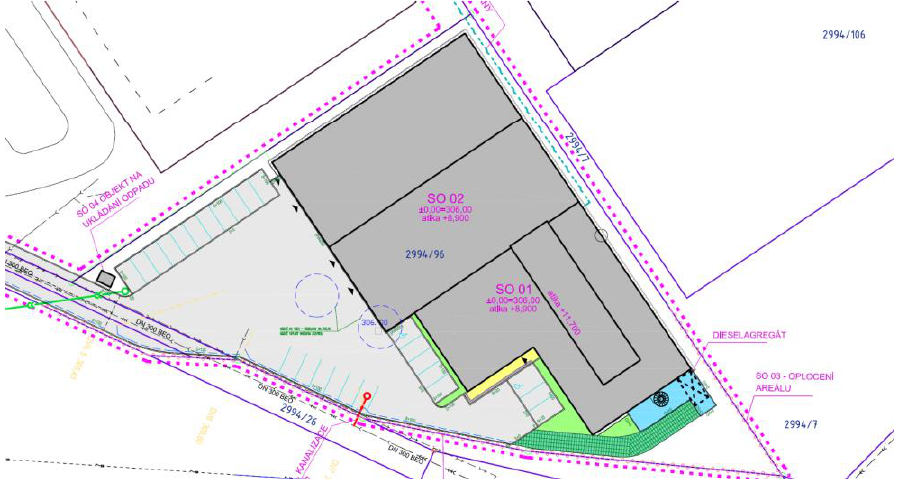
topografického zaměření pozemku a provedení podrobného hydrogeologického